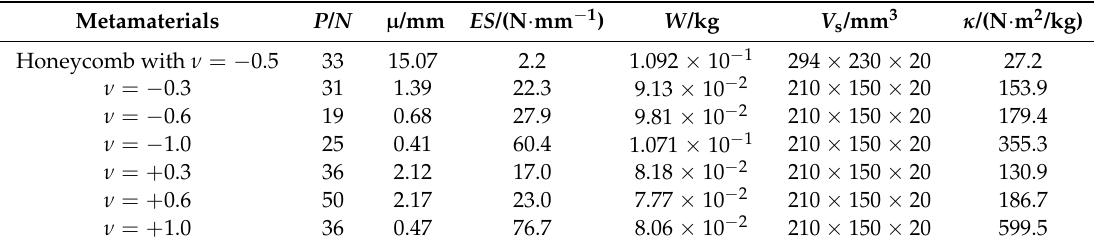
Table 2. In-plane specific stiffness of metamaterials.